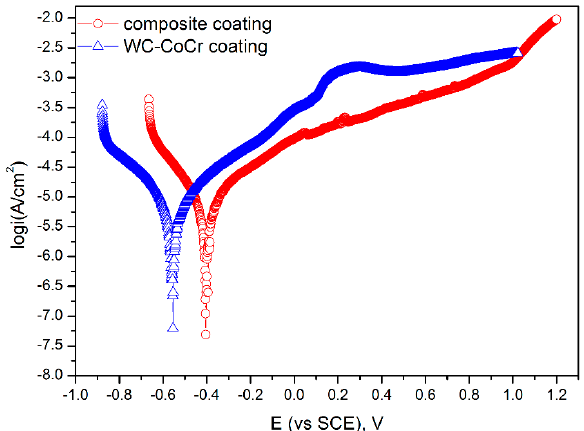
Figure 8. Potentiodynamic polarization curves of the as-sprayed coatings in 3.5 wt % NaCl solution.